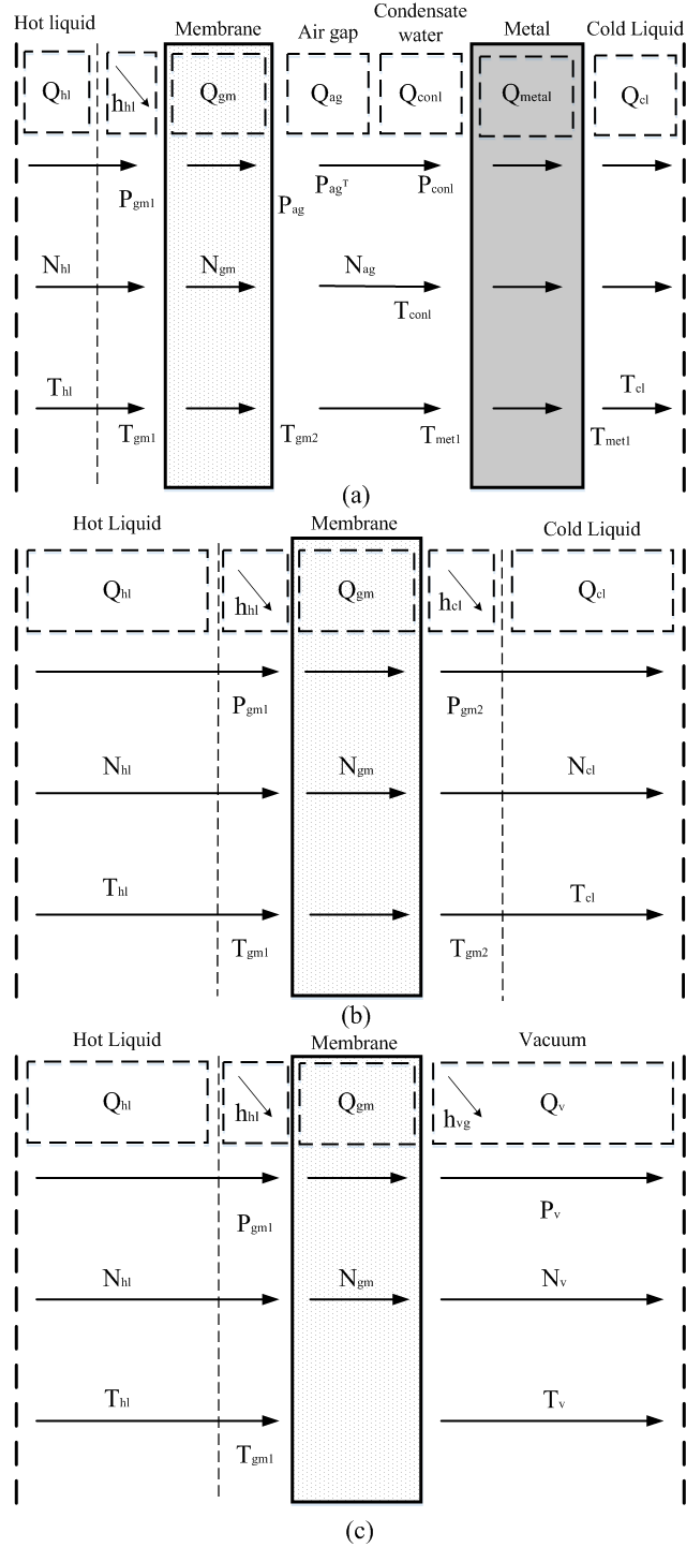
Figure 2. The variable notations of ( a ) AGMD, ( b ) DCMD, ( c ) VMD modules.